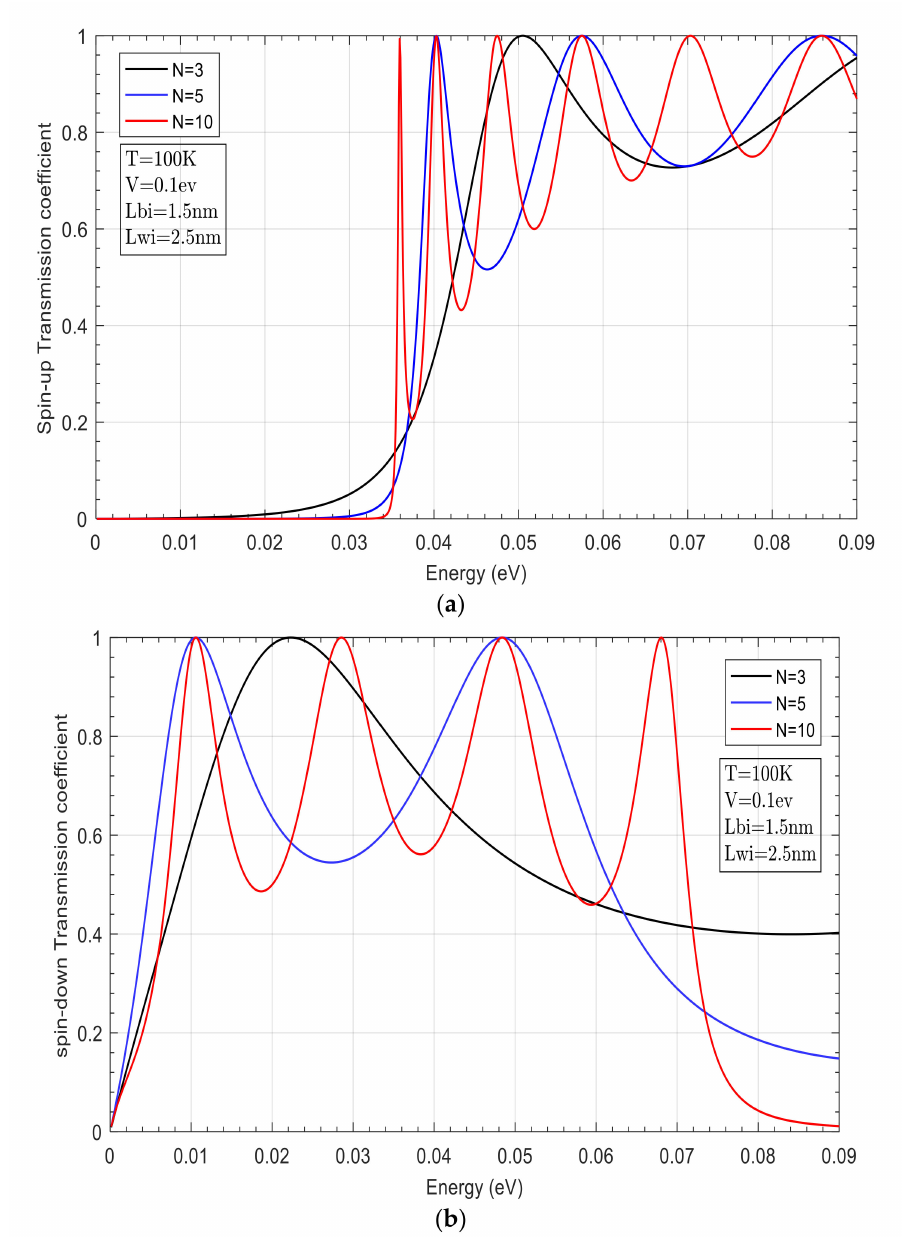
Figure 5. ( a ): The transmission coefficient of spin-up holes as a function of incident energy for three barrier numbers (N = 3, 5, and 10). T = 100 K. ( b ): The transmission coefficient of spin-up holes as a function of incident energy for three barrier numbers (N = 3, 5, and 10). T = 100